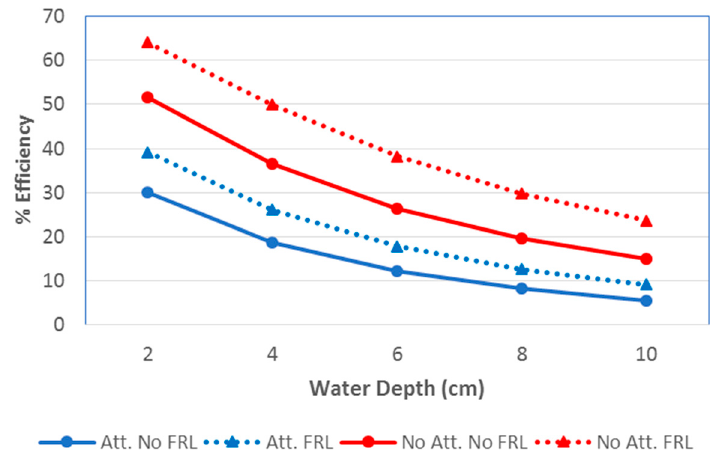
Figure 10. Theoretical efficiencies for different depths with and without using attenuation factor (Att.).